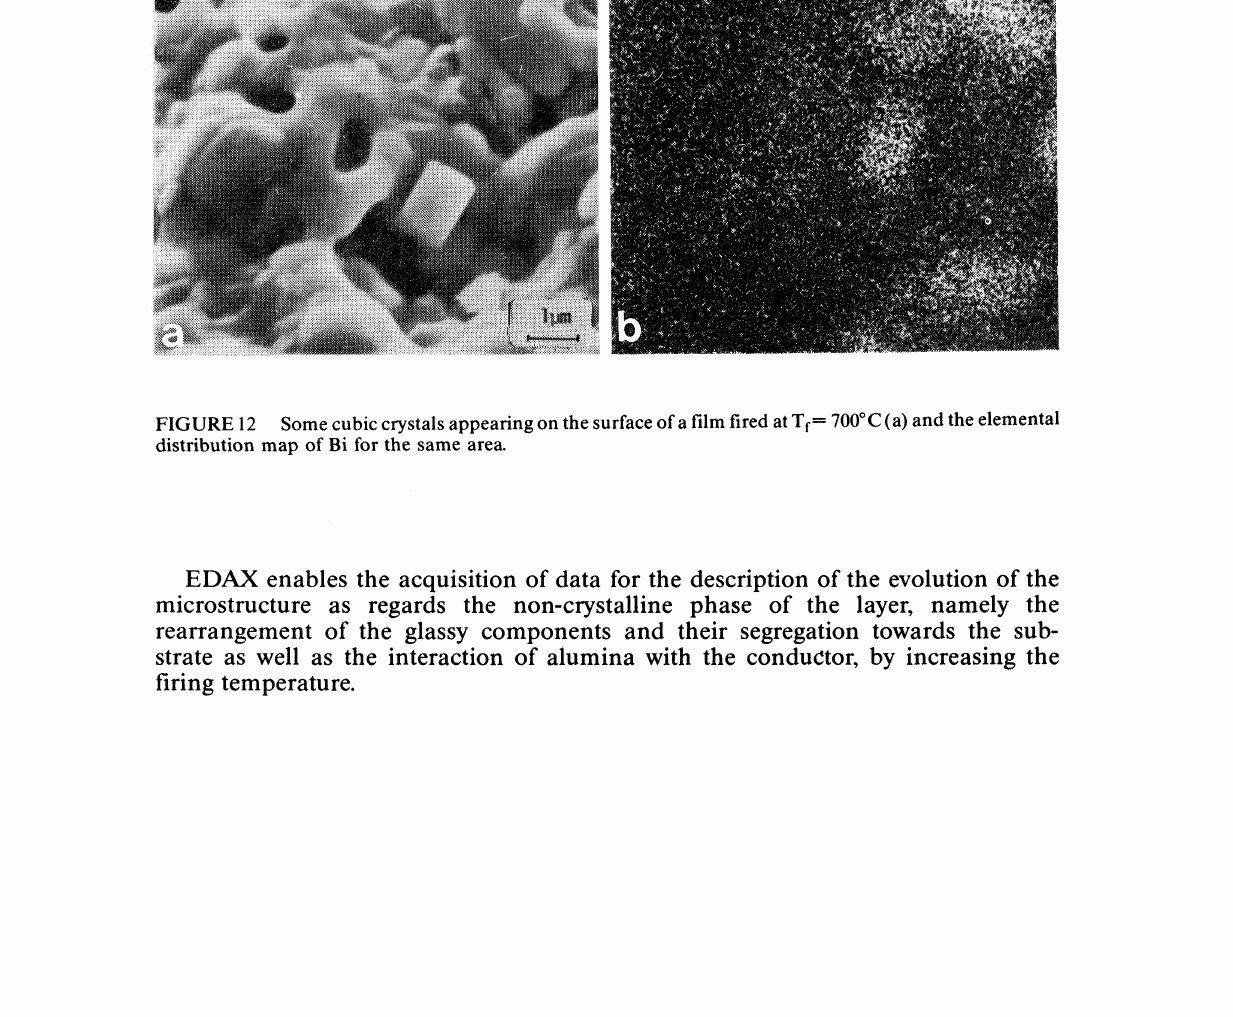
FIGURE 11 Cross sectional view of samples fired at Tf= 550C (a) and 850C (b). The difference in density and thickness should be noted.